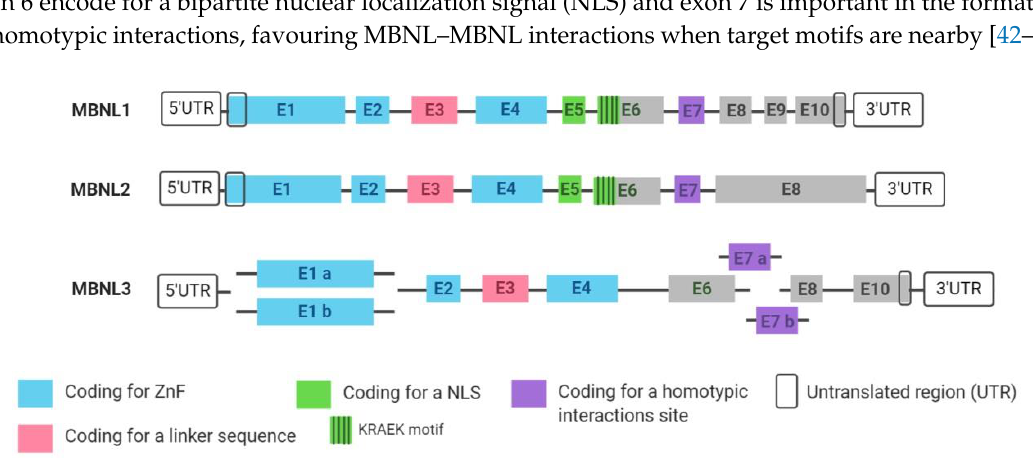
Figure 1. MBNL1, MBNL2 and MBNL3 paralog structures. All the exons that form the three MBNL paralogs are represented, each with its corresponding functional domains highlighted. Some of them are constitutively expressed in all transcripts but others undergone alternative splicing depending on the tissue or developmental process. ZnF = zinc finger; NLS = nuclear localization signal. Created with Biorender.com.